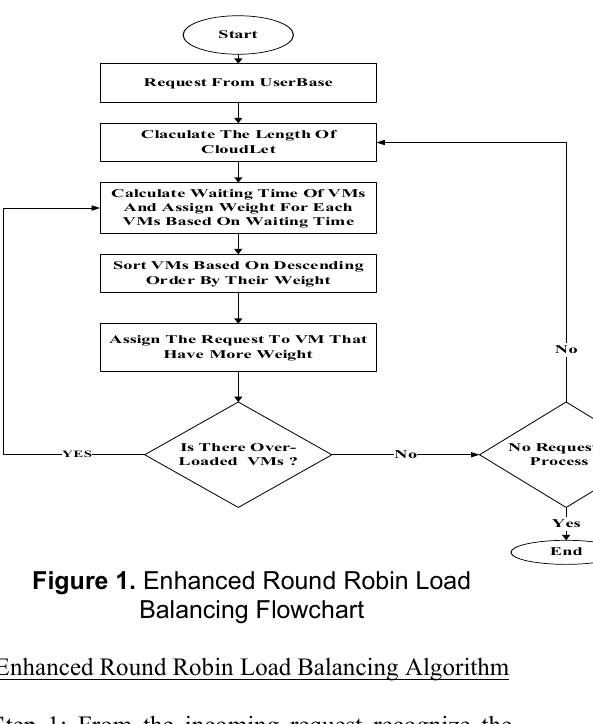
Figure 1. Enhanced Round Robin Load Balancing Flowchart Enhanced Round Robin Load Balancing Algorithm